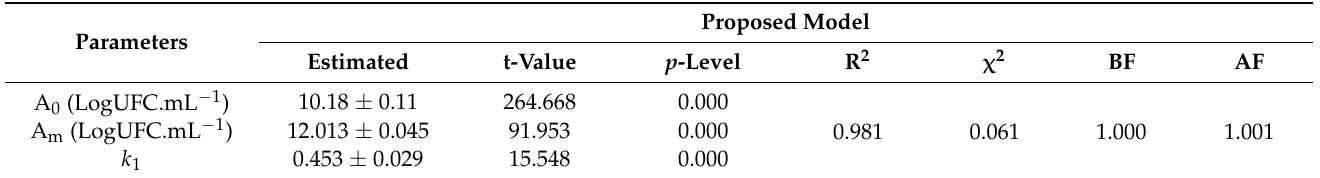
Table 4. Parameters of the proposed model for the cell growth process in the filmogenic solution.